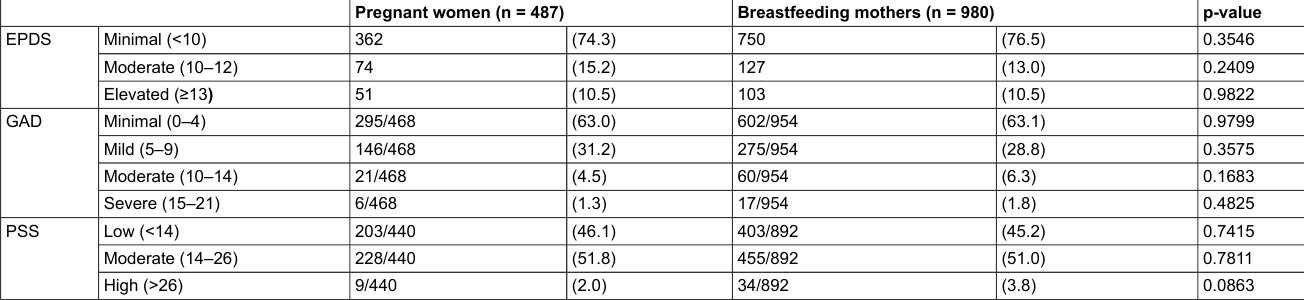
Table 2: EPDS (Edinburgh Depression Scale), GAD (General Anxiety Disorder) and PSS (Perceived Stress Scale) scores in 1467 patients. Pregnant women (n =